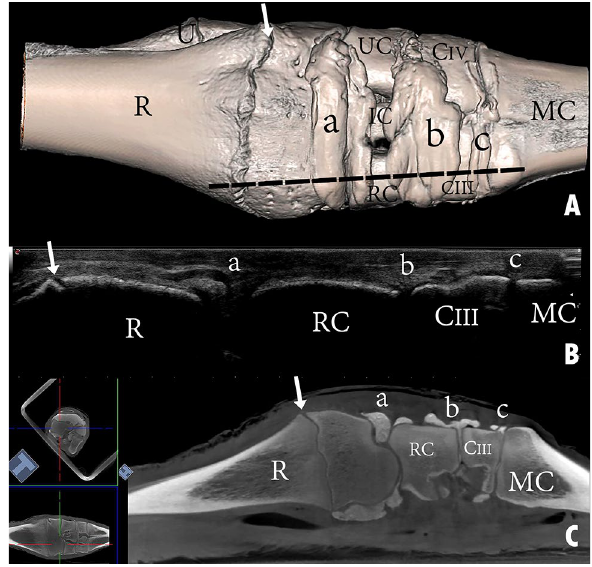
Figure 11. Dorsal view of a left carpal joint showing ( A ) three-dimensional reconstruction of the carpal joint (the black dotted line indicates the dorsomedial placement of the ultrasound probe); ( B ) longitudinal composed ultrasound image of the carpal joint; ( C ) sagittal plane computerized tomography image. R, the distal end of the radius; U, the distal end of the ulna; RC, radiocarpal bone; IC, intermediate carpal bone; UC, ulna carpal bone; CIII, carpal bone III; CIV, carpal bone IV; MC, metacarpal bone; a, radiocarpal joint cavity; b, intercarpal joint cavity; c, carpometacarpal joint cavity. The white arrow indicates the epiphysial line.